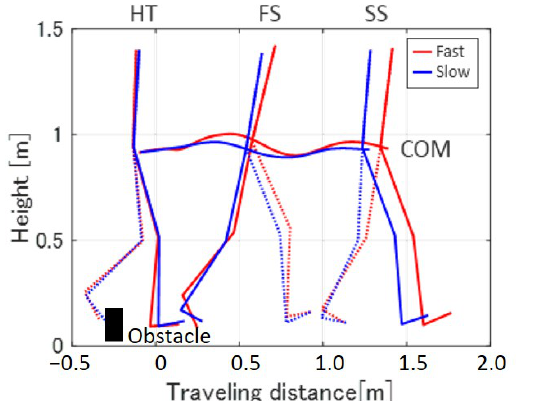
Figure 4. Stick picture of recovery steps. The horizontal position was adjusted considering the velocity of treadmill